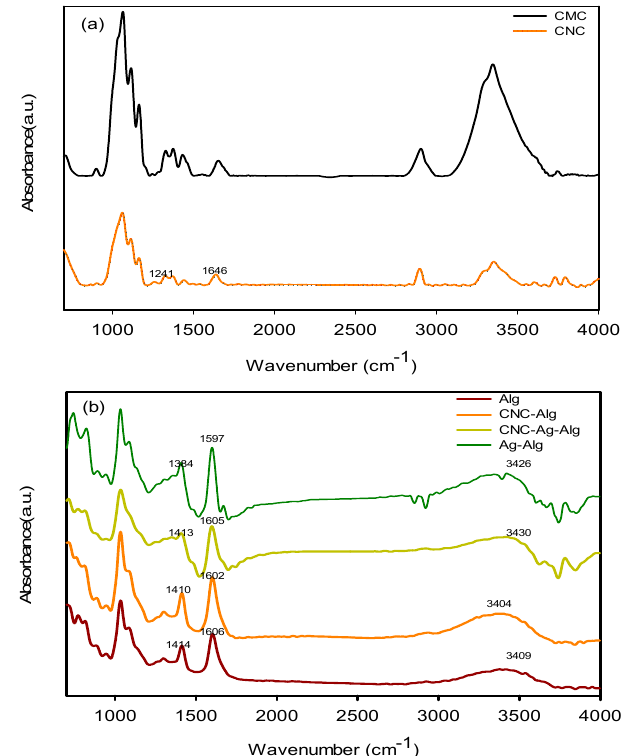
Figure 2. FTIR spectra of ( a ) cellulose microcrystal (CMC) and CNC ( b ) Alg, CNC / Alg, CNC / Ag / Alg, and Ag / Alg